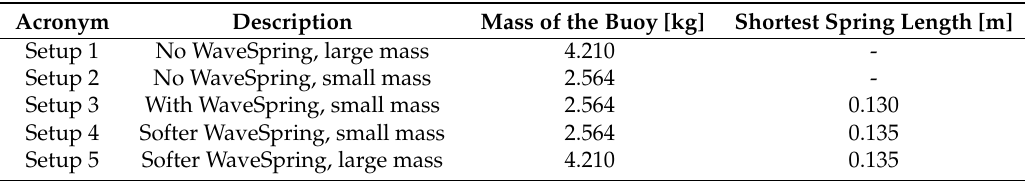
Table 2. Description of the setup configurations tested in the experimental